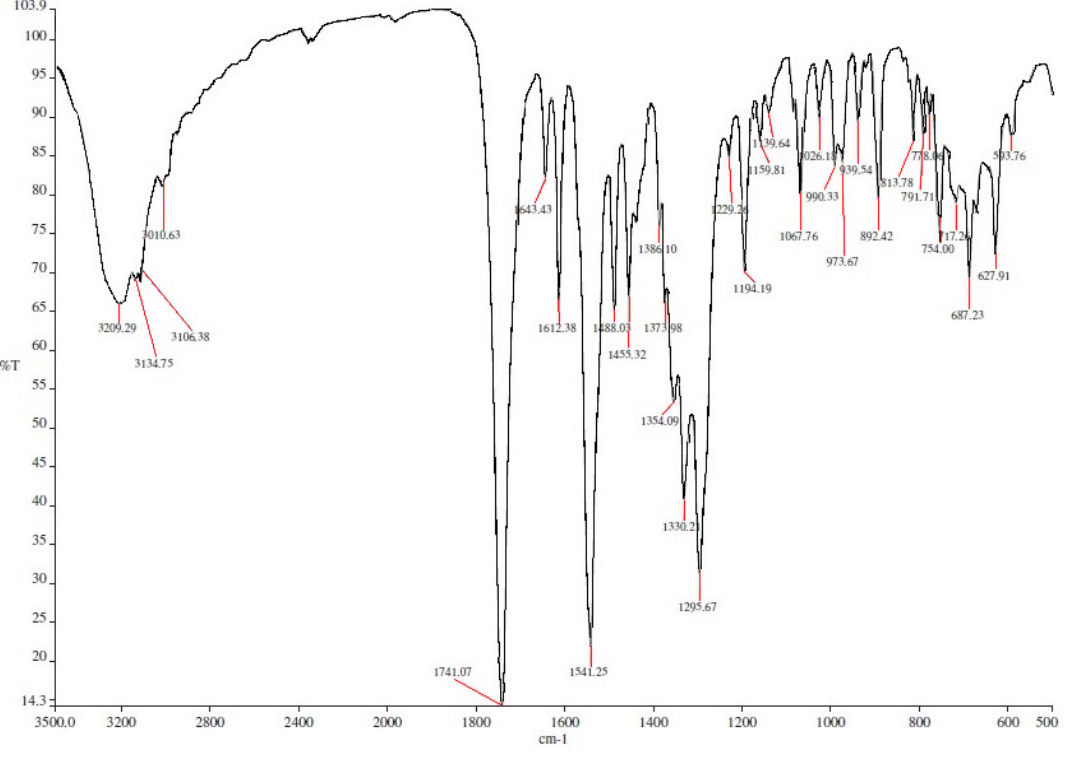
Figure 3. FT − IR spectrum of TriNBO